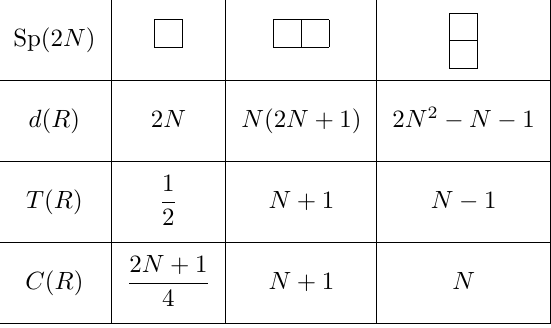
Table 1 . The dimension, Dynkin and Casimir of the smallest Sp(2 N )